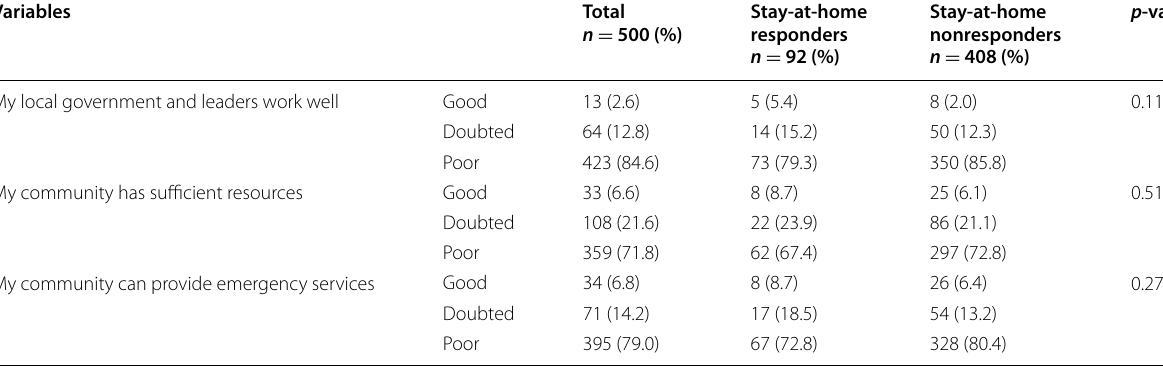
Values presented as number and percent were analyzed by chi-square test